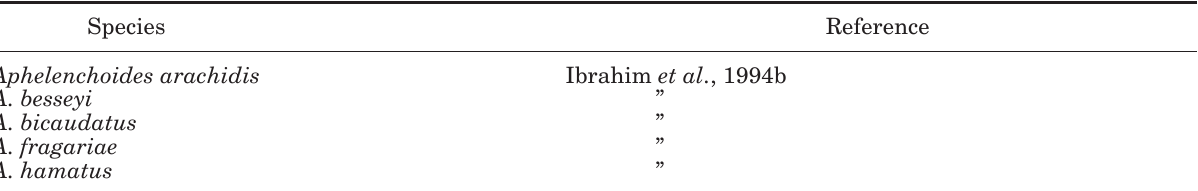
Table 2. Plant-parasitic nematode species characterized on the basis of proteins, using one-dimensional SDS gel electrophoresis.